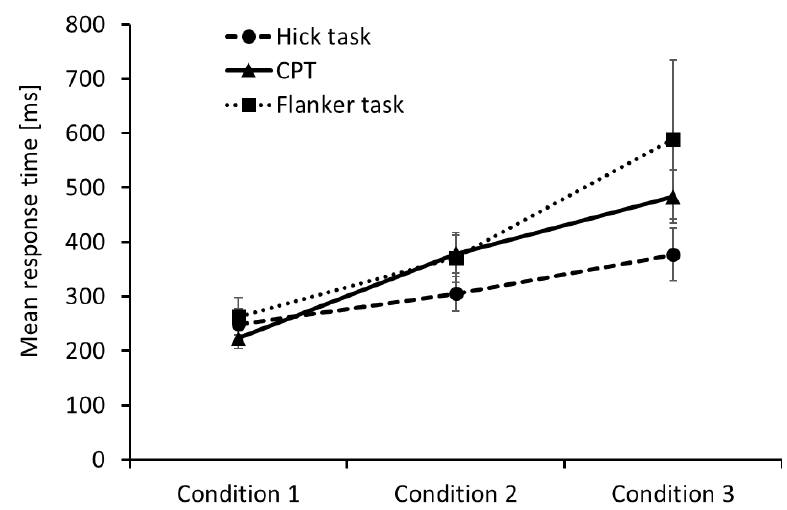
Figure 2. Mean response times in the three conditions of the flanker task, the continuous perfor- mance test (CPT), and the Hick task, respectively. Error bars represent the corresponding standard deviations.